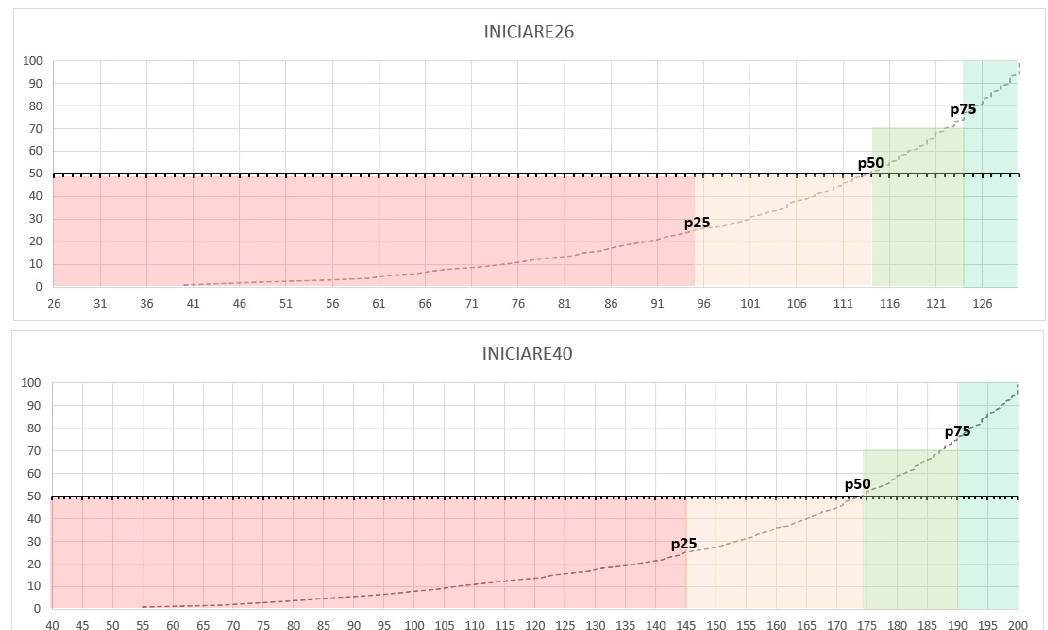
Figure 4. Percentile distribution Inventario del NIvel de Cuidados mediante Indicadores de Resultados de Enfermer í a (INICIARE)-26 and